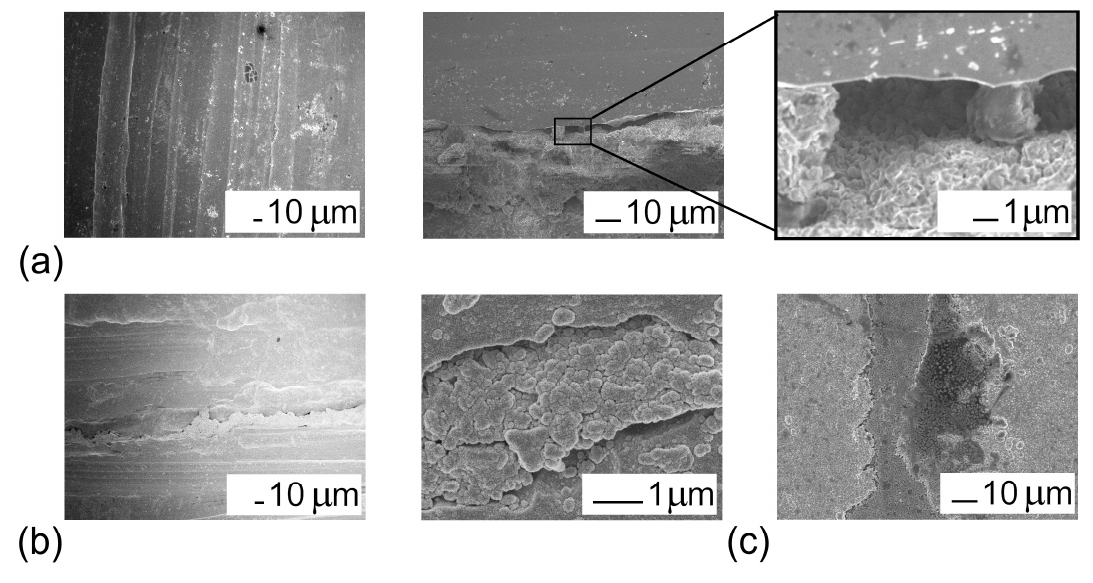
Figure 8. SEM micrographs of the surface defects of TiNi ( a ), Ir/TiNi ( b ), and Au/Ir/TiNi ( c )